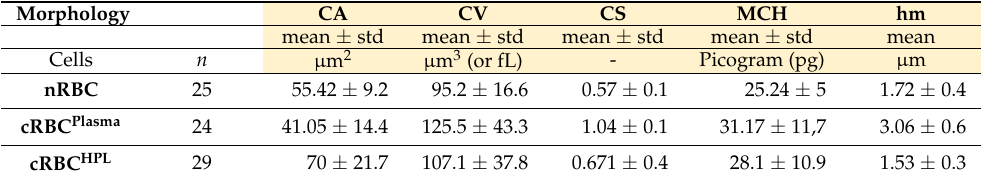
Table 2. Cell morphology parameters. CA : Cell area; CV : Cell volume; CS : Cell sphericity coeffi- cient; MCH : Mean corpuscular hemoglobin; hm : Equivalent cell height.